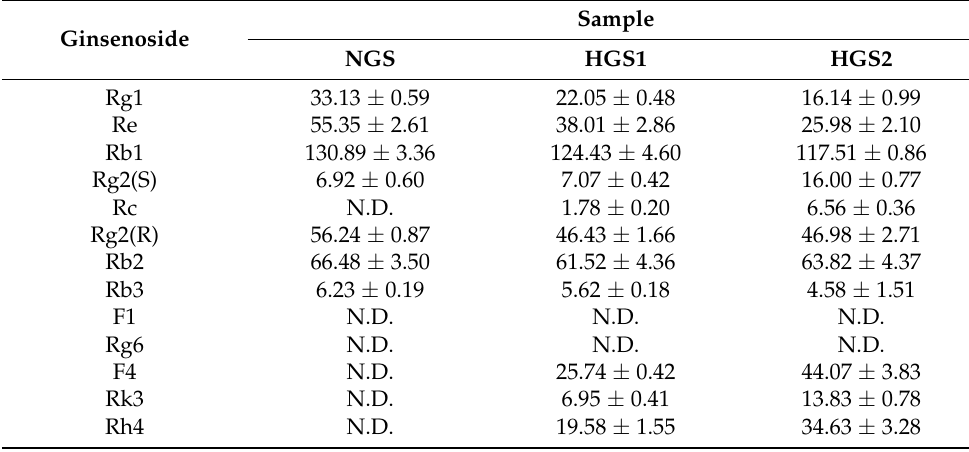
Table 1. Ginsenoside composition of crude ginseng saponin. Unit: